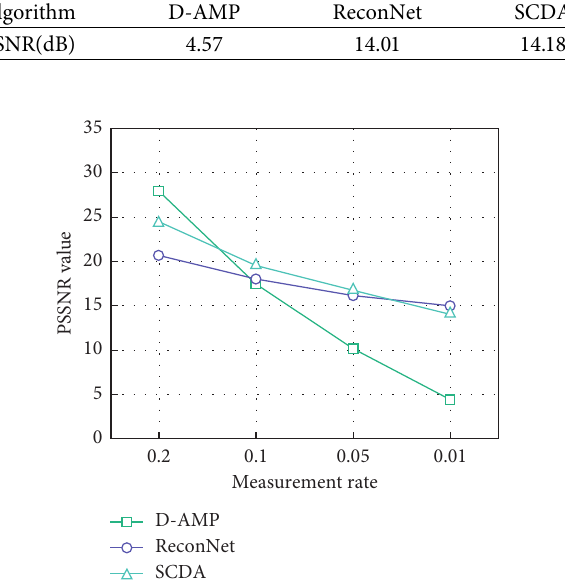
Figure 4: Reconstruction accuracy comparison results of D-AMP, ReconNet, and SCDA algorithms. Table 5: The average time required for the reconstruction process (the measurement rate is 0.20).